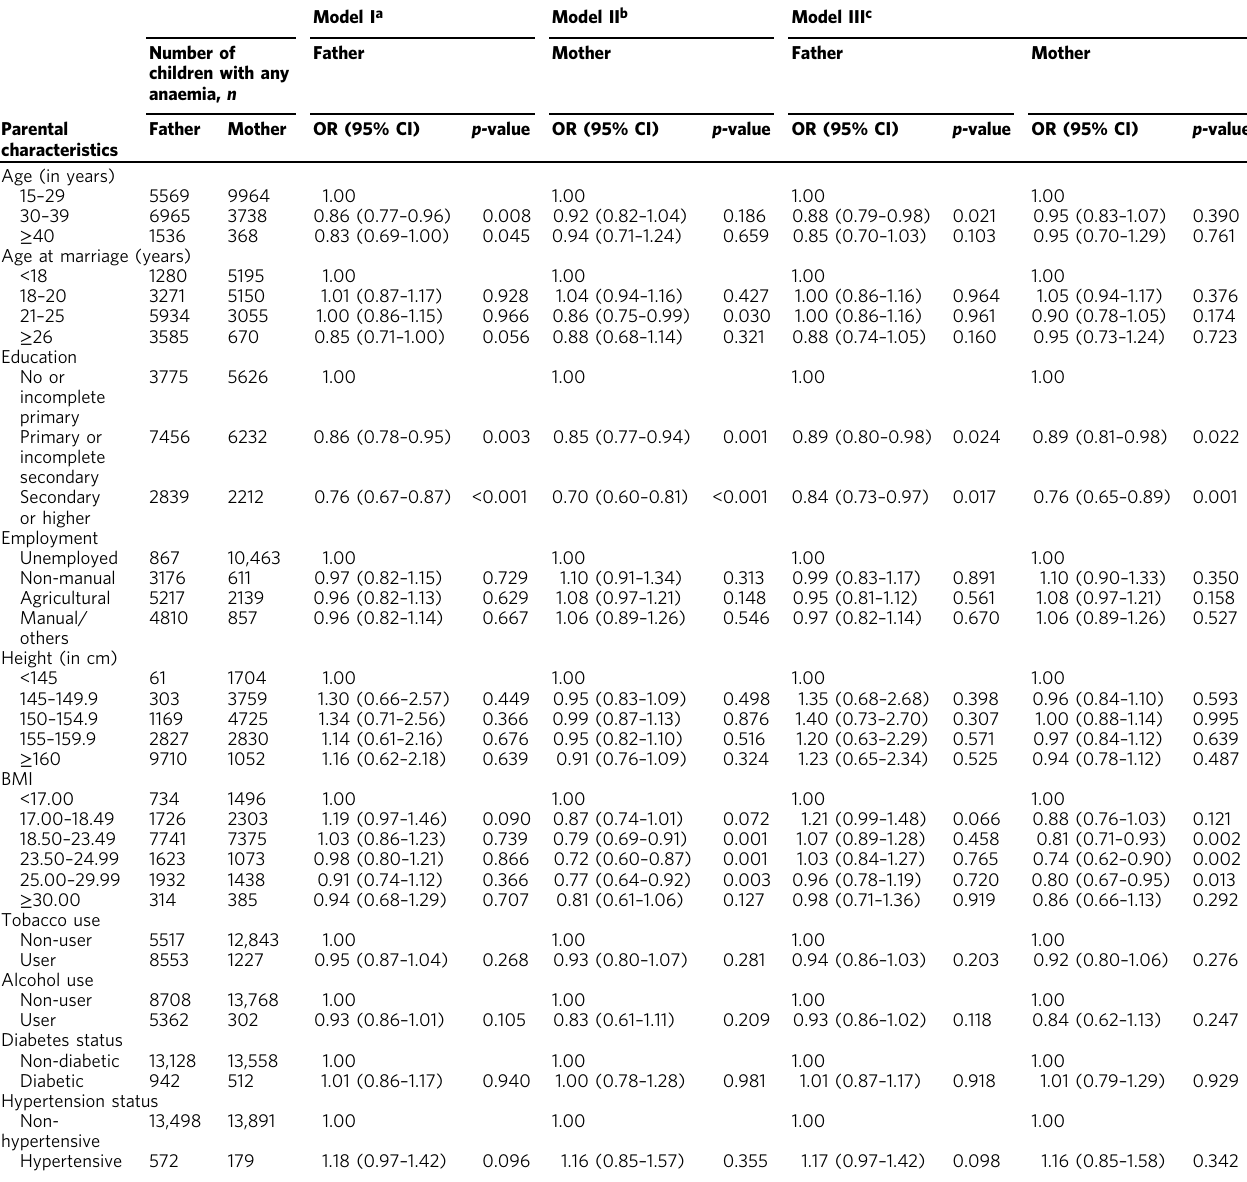
Table 3 Association between parental characteristics and any anaemia (aged 6 – 59 months). Model I a Model II b Model III